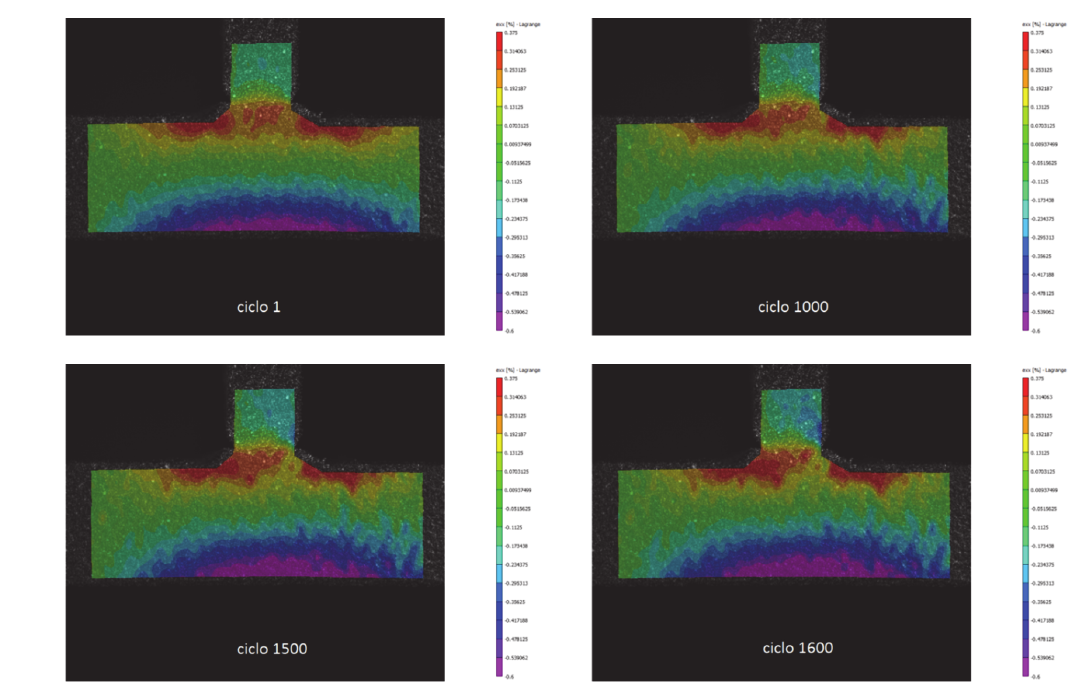
Figure 7: Horizontal strain ( ε x ) measured at maximum load (40 kN) using the digital image correlation for different load cycles.